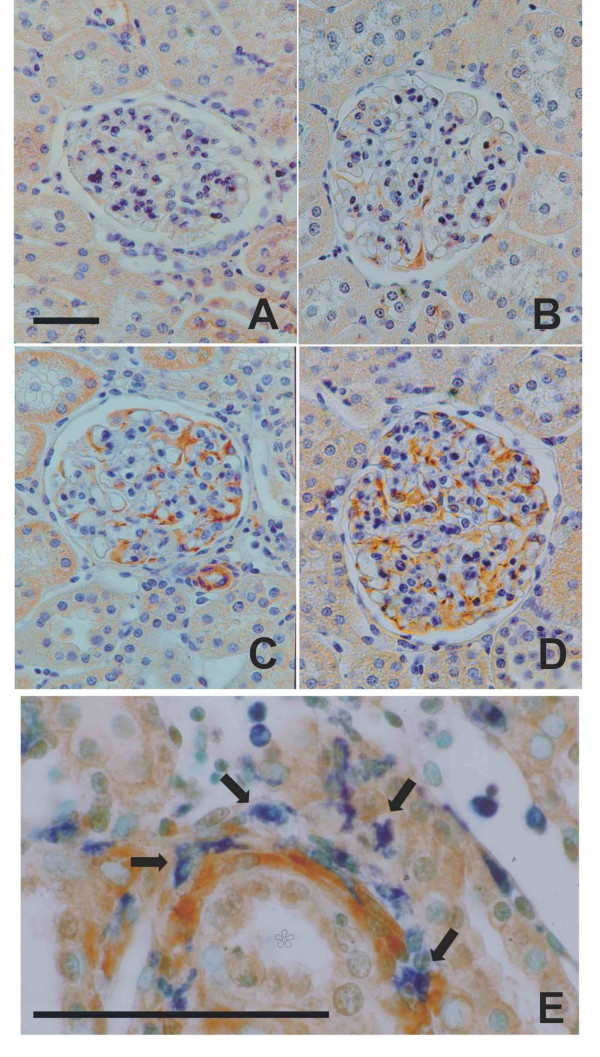
Immunohistochemistry for MCP-1 and the macrophage marker ED-1. Panel A-D: examples of photomicrographs of MCP-1 staining (brown) in glomeruli, hematoxylin counterstain (blue nuclei) Panel A (glomerulus of a normotensive normoglycemic rat) represents score 0, panel B (from a normotensive diabetic rat) score 1, panel C (from a hypertensive normoglycemic rat kidney) score 2, and panel D (from a hypertensive diabetic rat) score 3. Panel E, High power magnification of MCP-1 immunohistochemistry (brown) in a hypertensive diabetic rat. MCP-1 staining localized to spindle-shaped cells, probably fibroblasts, surrounding tubules in a double immunohistochemistry with the macrophage marker ED-1 (blue cytoplasm, arrows), methyl-green counterstain. Macrophages were often localized in close proximity to the MCP-1 positive cells surrounding tubules (asterisk). Scale bars (50 μm) are indicated. Note the identical scale for panels A-D but different scale for panel E.